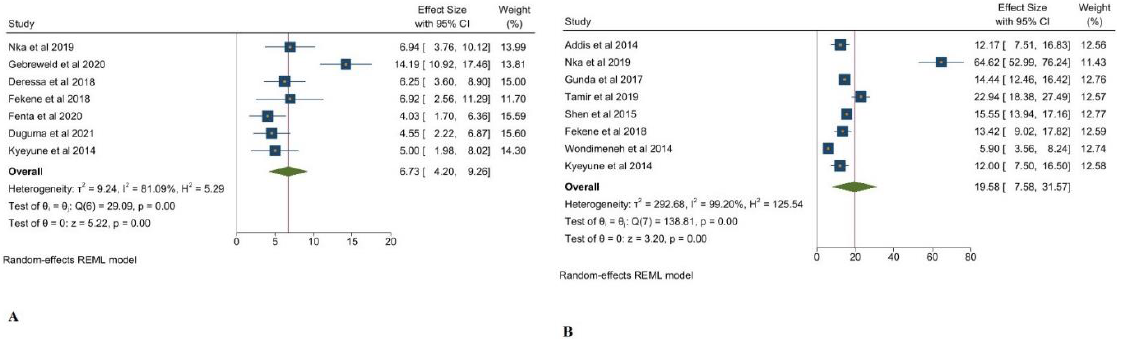
Figure 5. Pooled prevalence of thrombocytopenia in Female and Male. ( A ) Female, ( B ) Male [1,18–28].